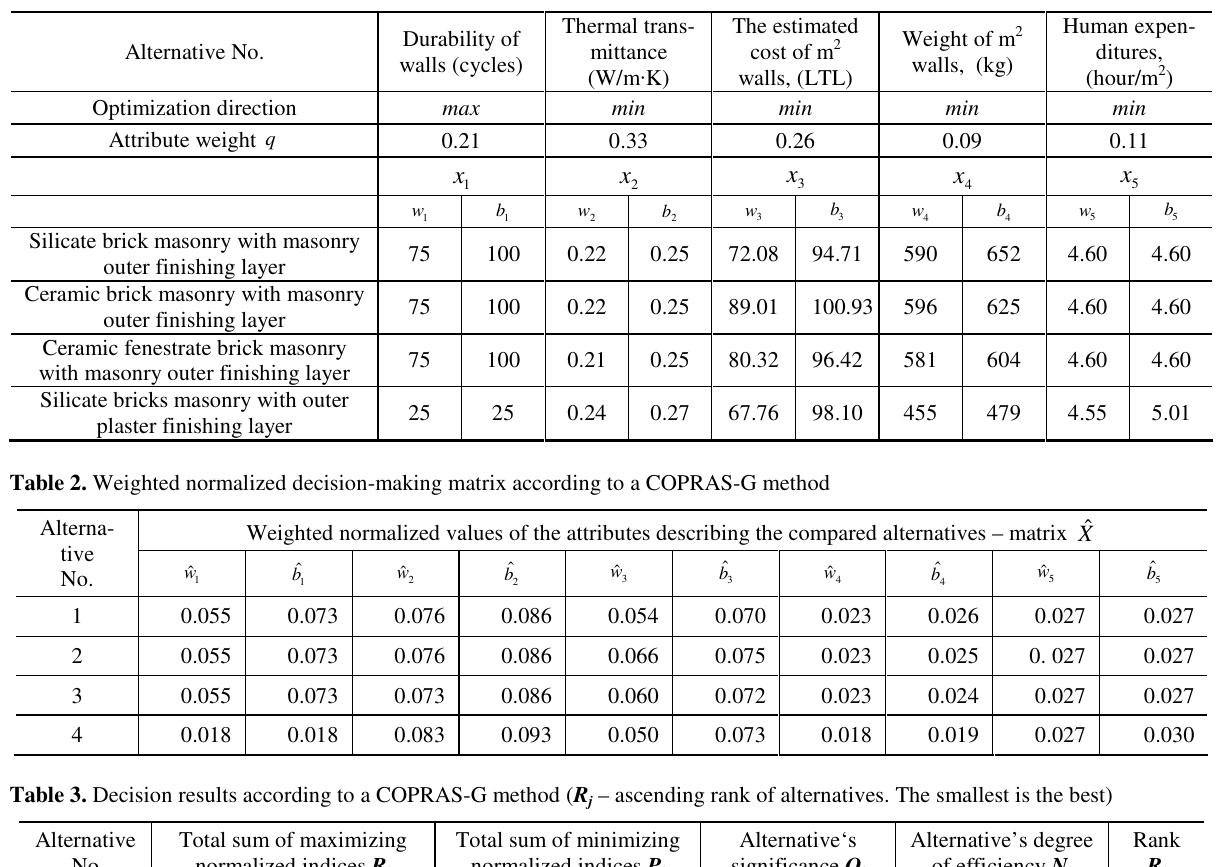
Table 1. Initial decision-making matrix with values expressed in intervals Alternative No.